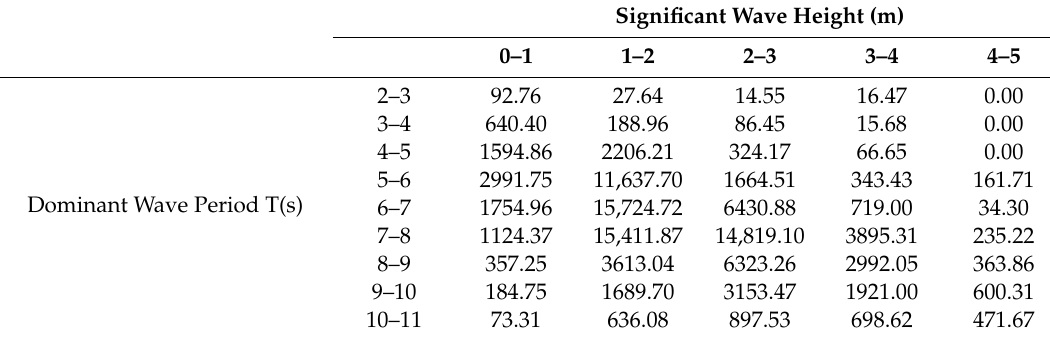
Table 2. Annual energy resource potential (kWh / m · y) based on hourly resolution data.